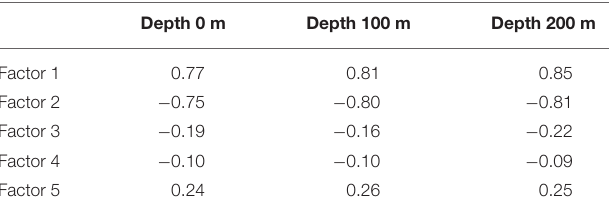
TABLE 1 | Pearson coefficients of linear correlation of factor loadings and summer sea temperature.